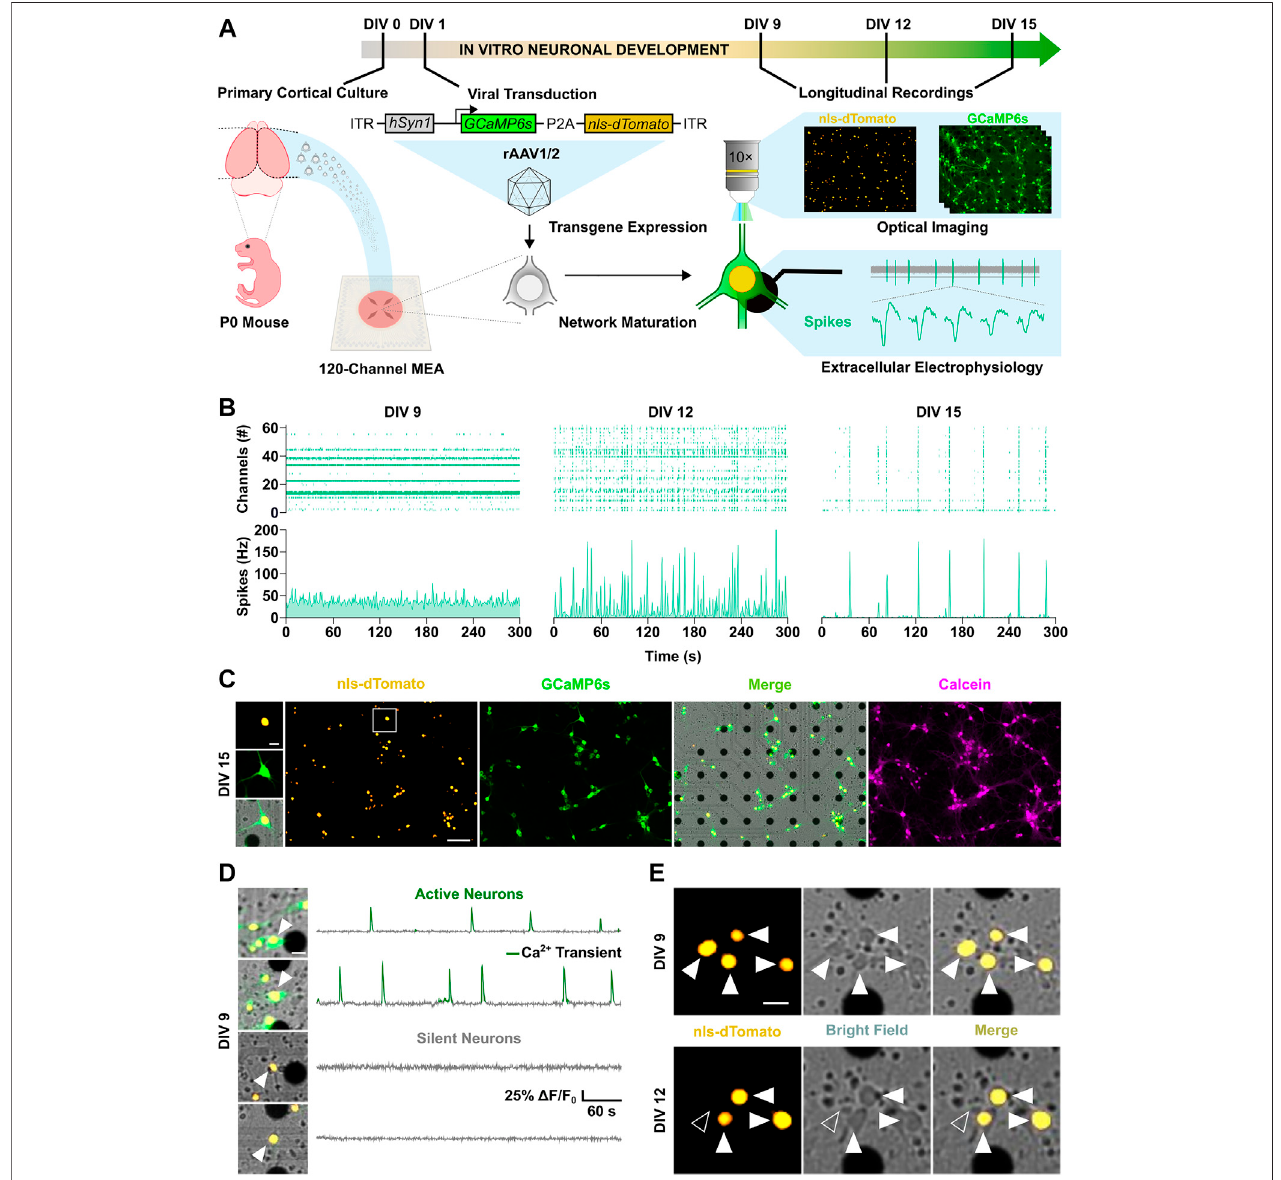
FIGURE 1 | Spatiotemporal investigation of neuronal activity and apoptosis in developing cortical cultures. (A) Schematic overview of the experimental design. (B) Longitudinal electrophysiological MEA recordings over the second week in vitro . Spike raster plots (top panels) of active channels across development are shown together with corresponding spike count histograms (bottom panels). (C) Live-cell imaging of nuclear tag nls-dTomato (yellow) and maximal projection of calcium indicator GCaMP6s signal (green) in cortical neurons cultured on a MEA. Merge (yellow-green) image with the bright fi eld channel highlights dark electrode tips. Post-hocstainingwithcalcein-AMdye(magenta)con fi rmedviabilityofidenti fi edneuronsthroughouttheexperiment. (D) Representativemergeimagesand fl uorescence traces of active (top) and silent neurons (bottom). Detected calcium transients are overlaid in green. (E) Longitudinal imaging of nuclear nls-dTomato signal allowed unbiased identi fi cation of neurons and reliable cell fate monitoring throughout the experimental time course. Surviving neurons are indicated by white arrowheads, whereas neurons with an apoptotic cell fate are marked by un fi lled arrowheads. Scale bars represent 100 µm in overview images (C) and 20 µm in cropped images of 100 × 100 µm (C – E)